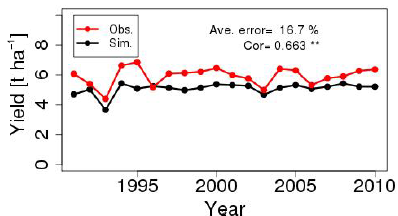
Figure 13. Comparison of yields over Japan between simulations and